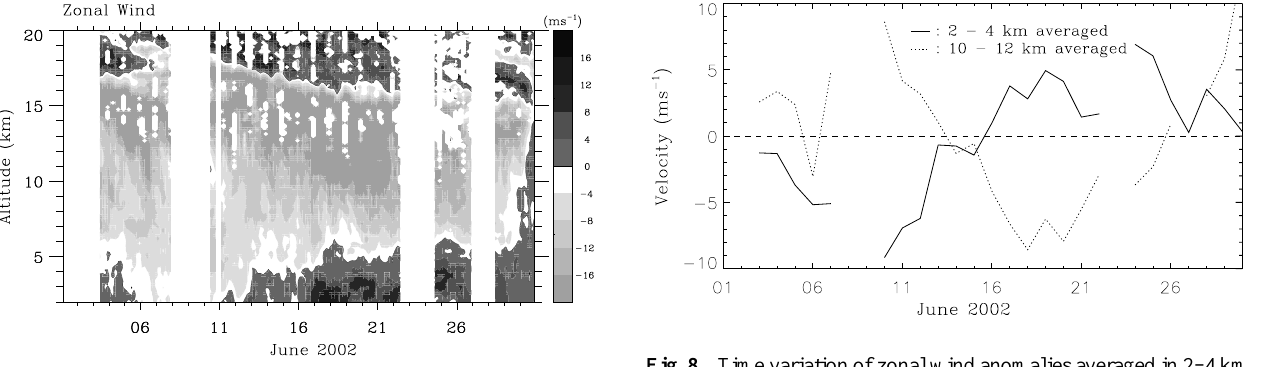
Fig. 8. Time variation of zonal wind anomalies averaged in 2–4 km (solid curve) and 10–12km (dotted curve) observed by EAR in June 2002. Æ N, Æ E), re- (cid:1) (cid:3)(cid:1)(cid:1)